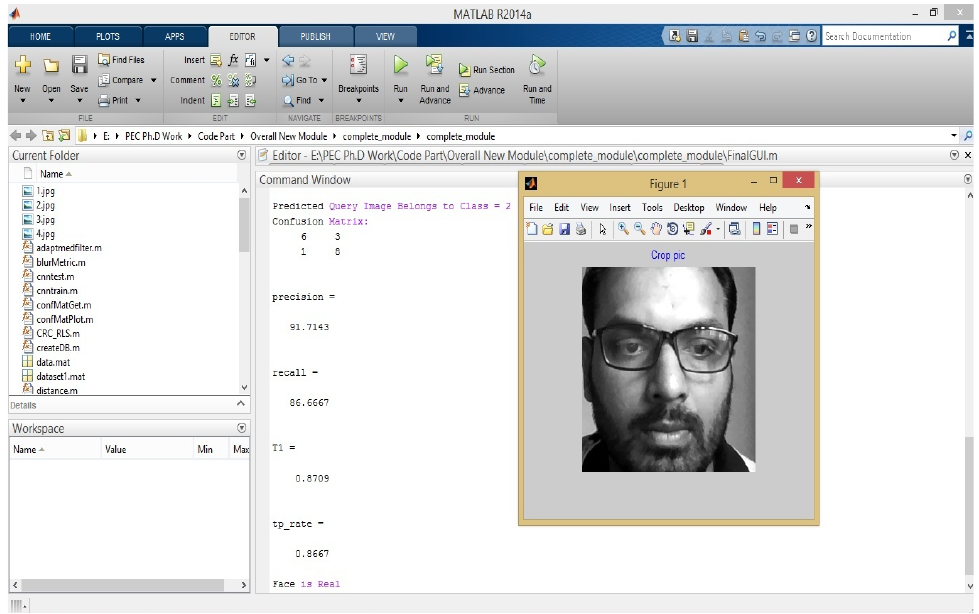
Figure 9. Results of Real-time face detection.